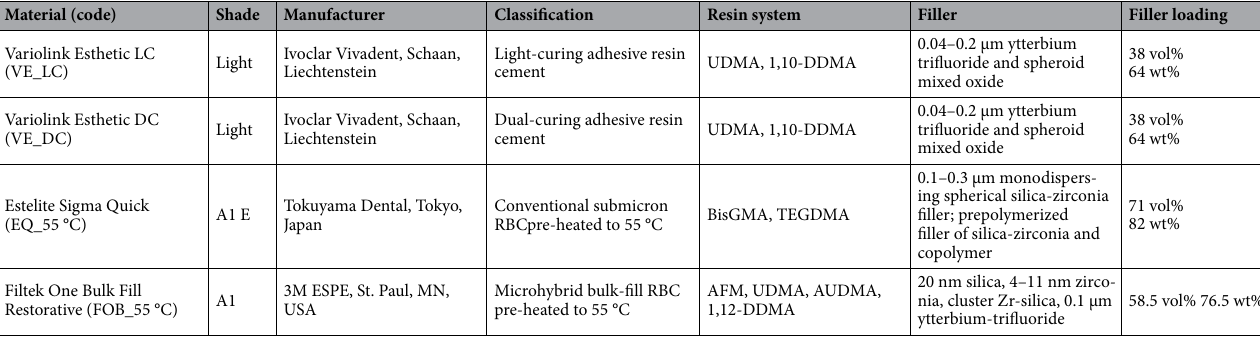
Table 1. Materials, manufacturers, classification and composition of the investigated adhesive resin cements and pre-heated resin-based composites. RBC resin-based composite, E enamel, BisGMA bisphenol-A diglycidil ether dimethacrylate, AFM addition fragmentation monomer, UDMA urethane dimethacrylate, AUDMA aromatic urethane dimethacrylate, 1,10-DDMA 1,10-dodecane dimethacrylate, 1,12-DDMA